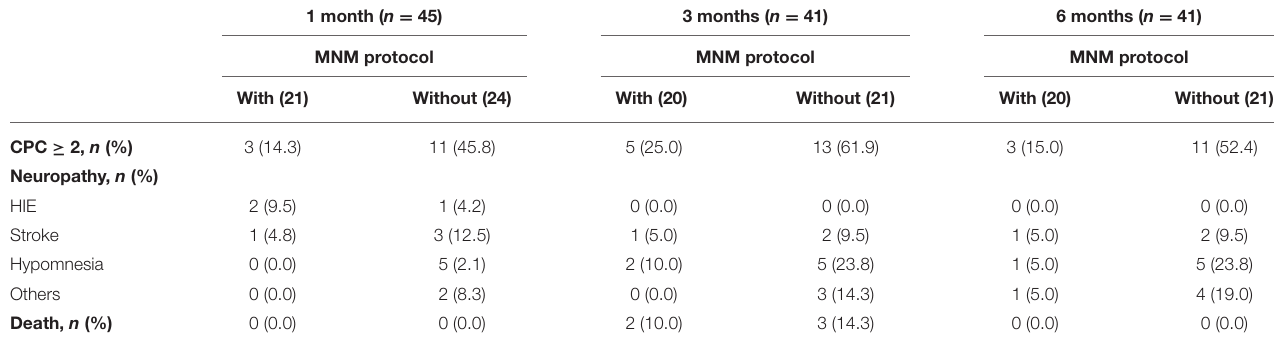
TABLE 5 | Long-term neurological outcomes after discharge.